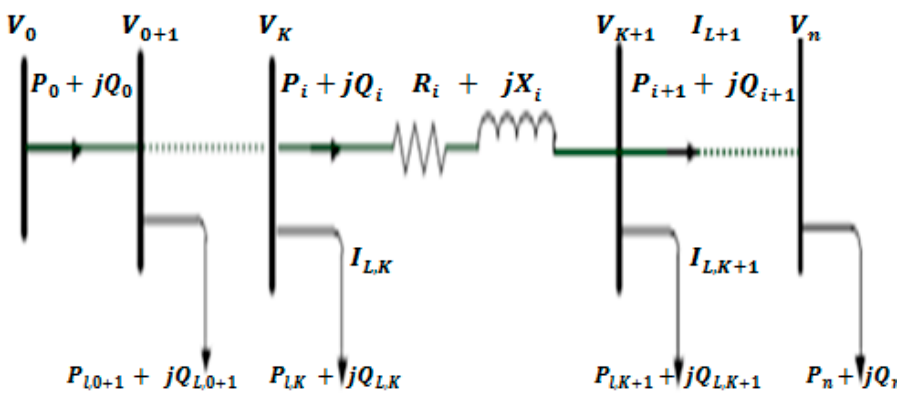
Figure 5. Layers in the radial distribution network (RDN).